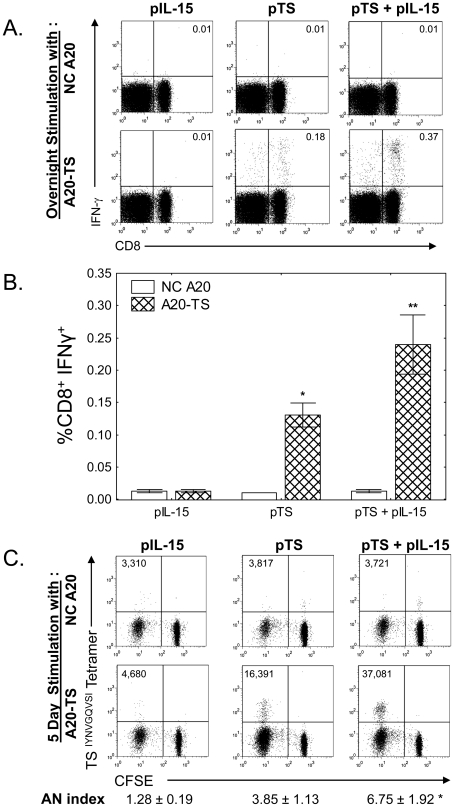
Persistent increases in CD8+ T cell frequencies and responsiveness after co-administration of pTS + pIL-15.BALB/c mice were vaccinated three times, 2 weeks apart with pIL-15, pTS, or pIL-15+pTS. Six months later, spleen cells (N = 4/group) were cultured overnight with negative control (NC A20) or TS-expressing APC (A20-TS), then ICS performed for quantitation of TS-specific IFN-γ producing CD8+ T cells (A and B, shown are frequencies of CD3+ T cells). Spleen cells from mice vaccinated with pTS + pIL-15 exhibited much higher frequencies of TS-specific IFN-γ expressing CD8+ T cells compared with spleen cells from mice vaccinated with pTS alone (representative results shown in A; cumulative data from 4 individual mice per group in B). In order to study expansion capacities of TS-specific CD8+ T cells, spleen cells from mice obtained 6 months post vaccination (N = 4 per group) were labeled with CFSE and co-cultured with irradiated negative control A20 or A20-TS APCs. On day 5, T cells were stained for T cell surface markers including a tetramer reagent specific for TCR reactive with an immunodominant H2Kd-restricted epitope (TSKd1) and studied by flow cytometry (gated on CD8+ T cells). Shown in Panel C are the absolute numbers of TSKd1-specific T cells (in upper left of FACS plots), and the expansion indices of TSKd1-specific T cells detected in these assays (AN index = absolute number of TSKd1-specific cells after A20-TS expansion ÷ absolute number of TSKd1-specific cells after NC A20 expansion.) Vaccination with pTS + pIL-15 resulted in significant enhancement of TSKd1–specific CD8+ T cell responses capable of lymphoproliferative expansion. (* P<0.05 in comparison with pIL-15 alone group, ** P<0.05 in comparison with pIL-15 alone and pTS alone vaccine groups by Mann Whitney U tests.) Data representative of 2 experiments.